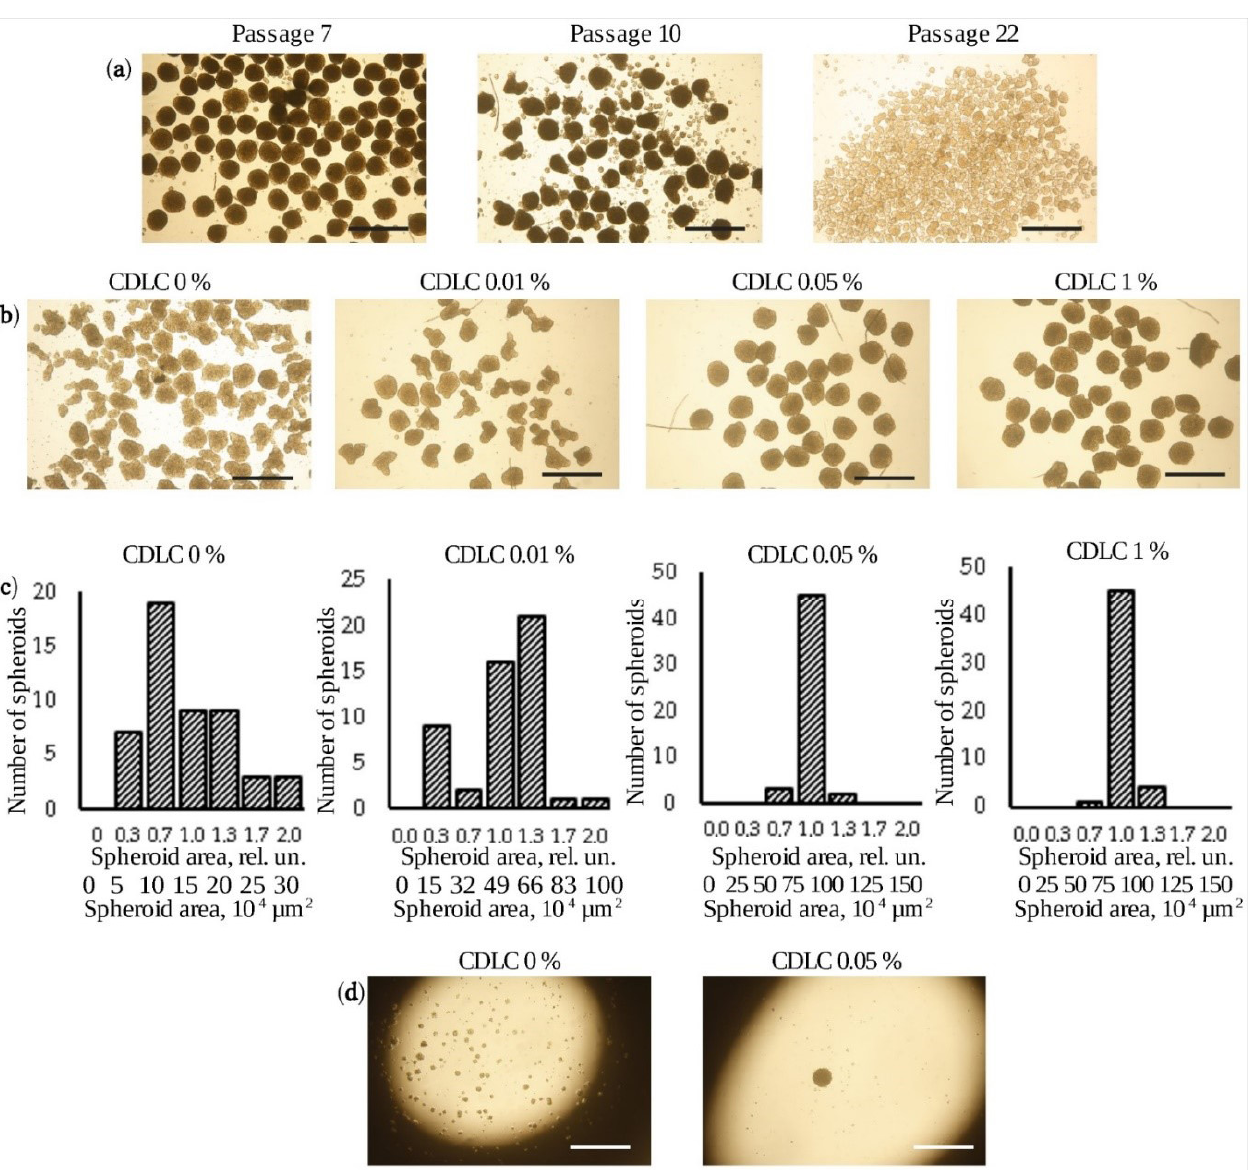
registered for MSCs obtained from bone marrow and adipose tissue (Figure S1a,b).